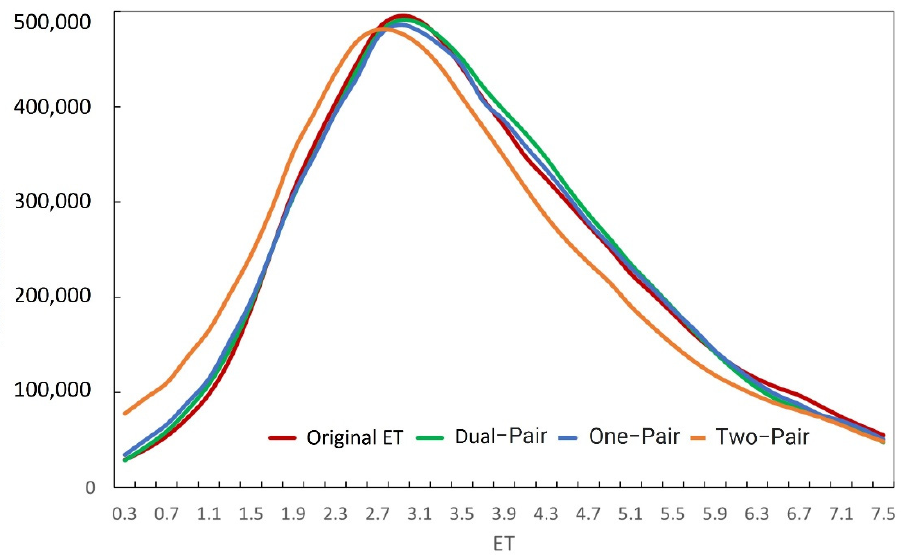
Figure 5. Histogram of average ET reproduced using the three fusion methods compared average ET from the direct retrievals.